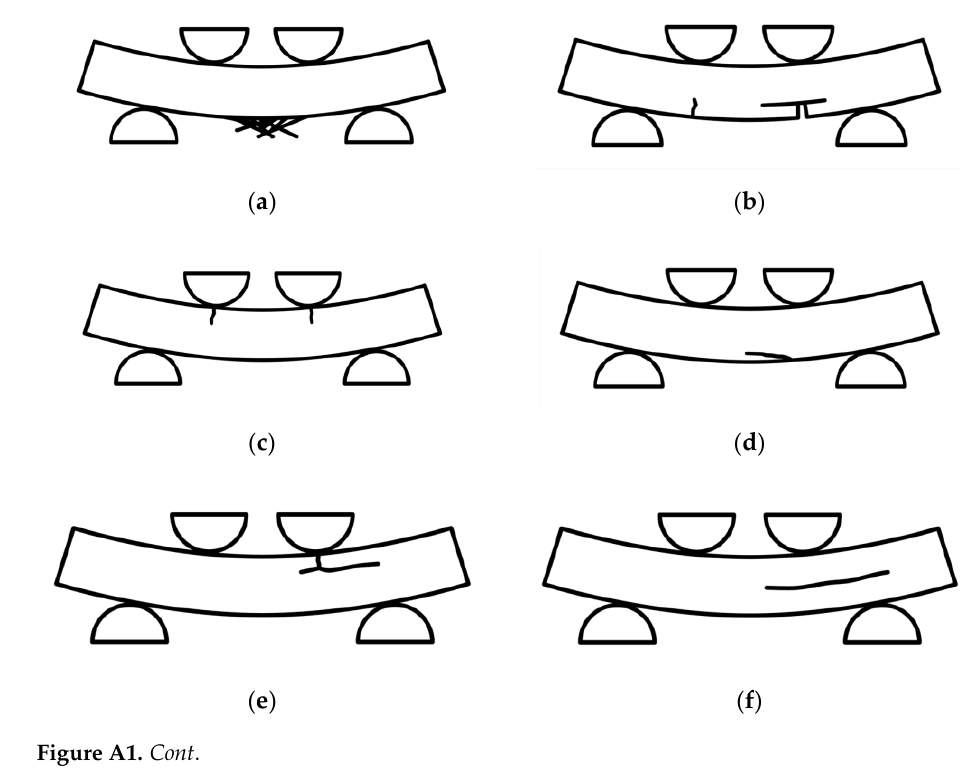
( j ) Figure A1. Failure modes in the four-point bending tests. The naming of the failure type matches the label of the subfigure. ( a ) Fiber fracture triggered by tensile stresses resulting in fibers sticking out of the sample surface in the lower center; ( b ) matrix cracking and local fracture triggered by tensile stresses opposite to the upper load induction; ( c ) matrix cracking and local fracture triggered by compression at the upper load induction points; ( d ) fracture triggered by interlaminar shear and tensile stresses at the bottom center; ( e ) fracture triggered by interlaminar shear and compression stresses at the top; ( f ) fracture triggered by interlaminar shear stresses at the sample middle; ( g ) matrix cracking and local fracture triggered by compression at the upper center; ( h ) fracture